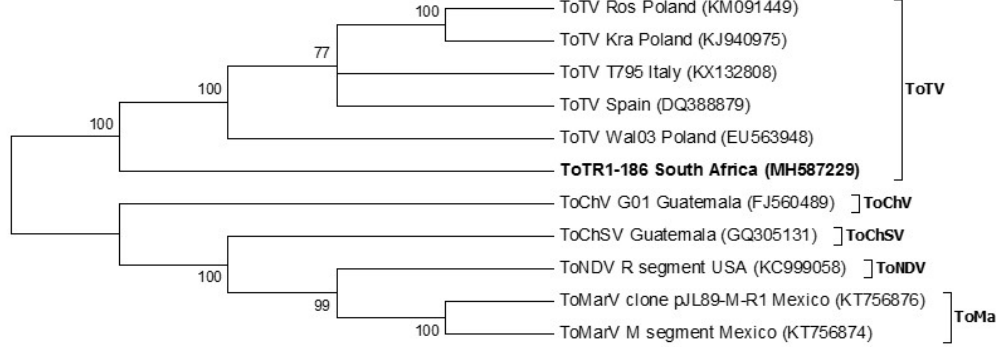
Figure 3. Phylogenetic relationship of the full-length ToTV RNA-1 genome from South Africa (ToTR1-186) with all other fully sequenced tomato-infecting torradovirus isolates to date. Evolutionary analysis was inferred using the maximum likelihood method and 1000 bootstrap replicates based on the general time reversible model [23]. A gamma distribution rate ( g = 5) was used to model evolutionary differences among sites. A rate variation model allowed some sites to be evolutionary invariable ( I ). Accession numbers are in parenthesis.